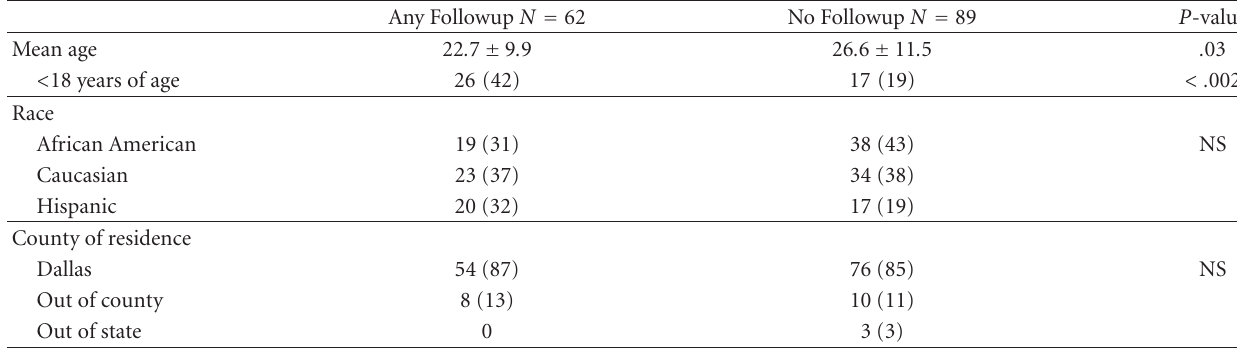
Table 6: Comparison of women who presented for followup to those with no